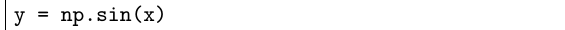
Also, the coordinate region that is shown goes towards slightly bigger x values than necessary — on the right- hand side, the curve is hanging in the air. In the y direc- tion, on the other hand, we could use a bit more space, since the curve is touching the axis box, and that makes the regions near the maxima and minima less easy to see. We solve both problems by explicitly setting the xlim and ylim ranges, stating both the lowest and the highest value: plt.clf() plt.xlabel(’Time in seconds’) plt.ylabel(’Pendulum angle [arbitrary units]’) plt.xlim(0,2*np.pi) plt.ylim(-1.1,1.1) plt.plot(x,y) The resulting curve, with custom range and axis names, can be seen in Fig. 83. That’s better.